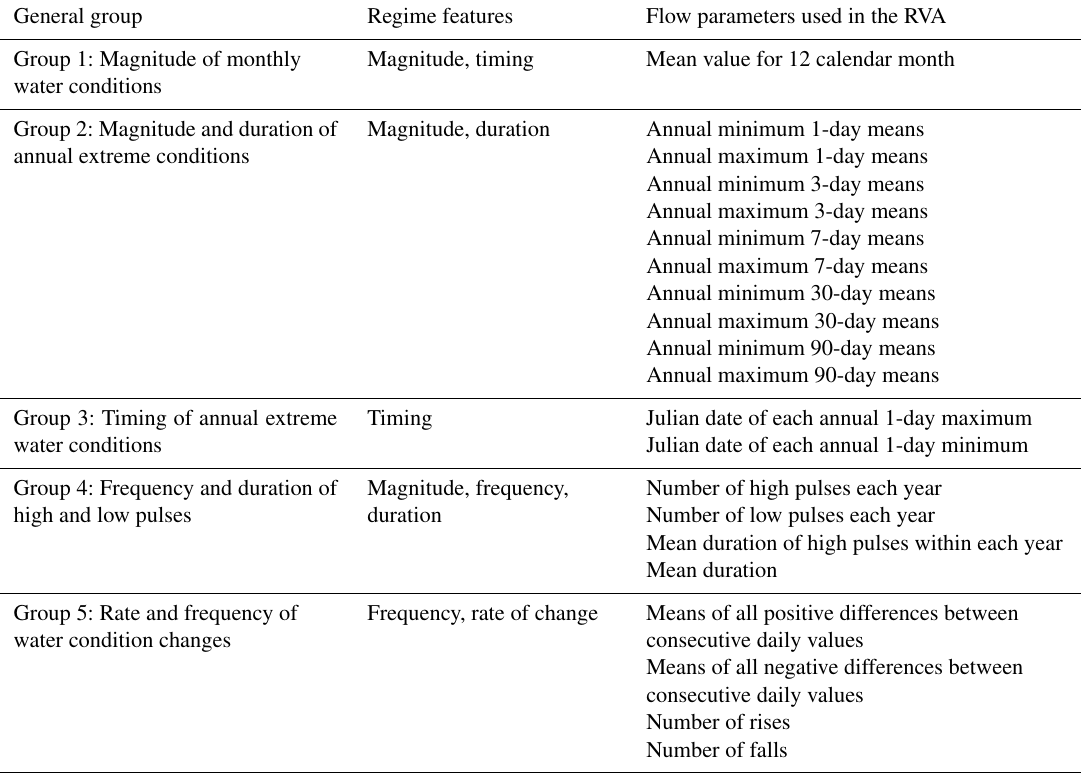
Table 2. Summary of hydrologic parameters used in the IHA, and their features (Richter et al., 1997). General group Regime